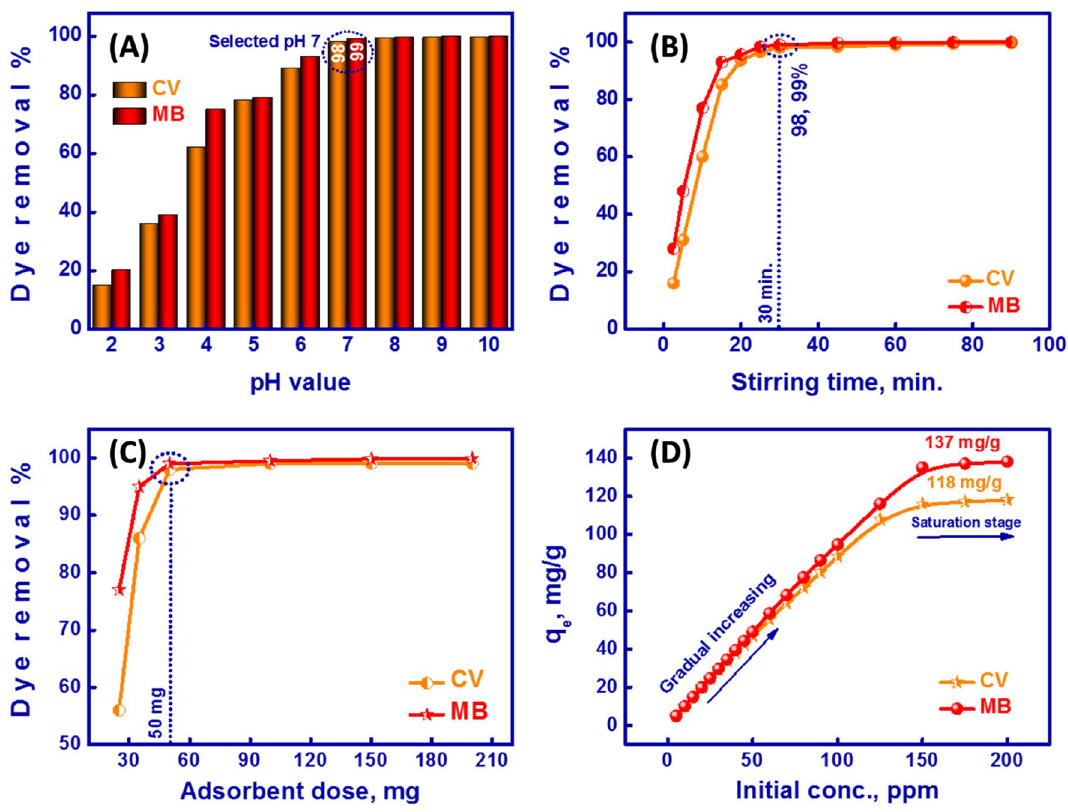
Figure 5. ( A ) Effect of pH, ( B ) Stirring time, ( C ) MMT-mAmCs dosage and ( D ) MB/CV concentration on the- removal % and capacity using MMT-mAmCs.